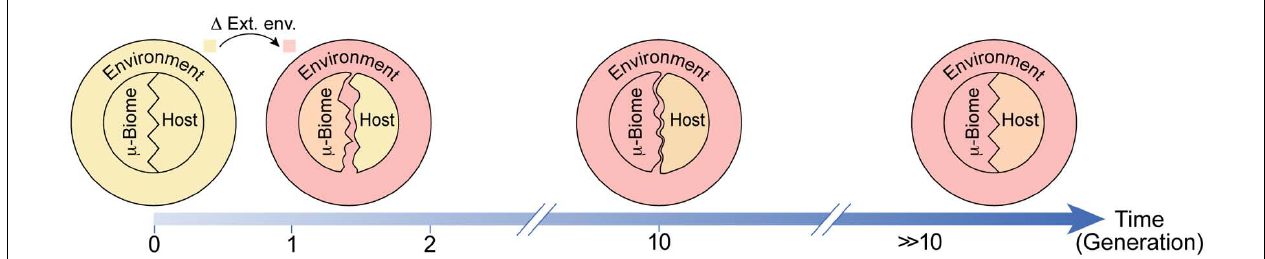
transition, the host is only mildly changed while the microbiome is considerably more adapted to the new environment (closer in color to the new environment).This difference in responsiveness disrupts the compatibility between the host and its microbiome (unmatched patterns). With time, the host and its microbiome become progressively more adapted to the environment and to one